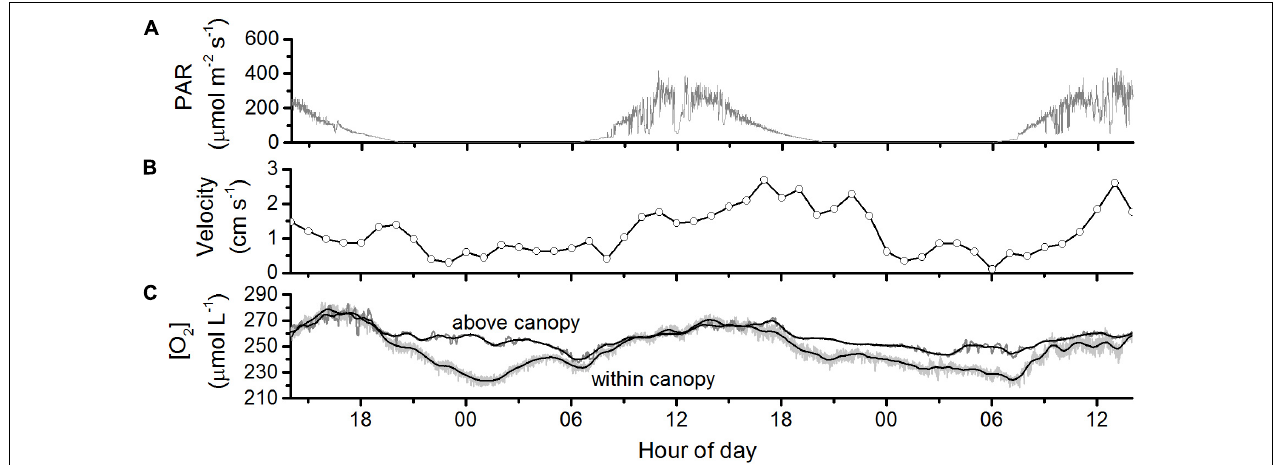
FIGURE 2 | Diel changes in (A) photosynthetically active radiation (PAR), (B) water velocity, and (C) dissolved oxygen at the open-water seagrass meadow in May of 2016. Dissolved oxygen was measured immediately above the canopy and within it (0.2 m above the bed). Higher variance in the O 2 signal within the canopy is due to lower sensor